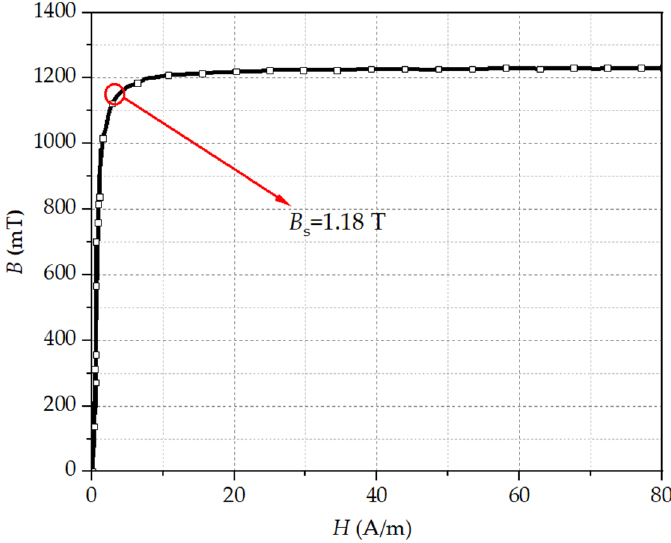
Figure 2. B –H curve of nanocrystalline material. Figure 2. B–H curve of nanocrystalline material.